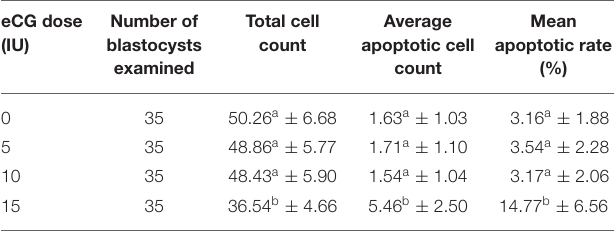
The values are shown as the means ± SDs. a , b Different superscripts within the same column indicate statistically significant differences (P < 0.05).